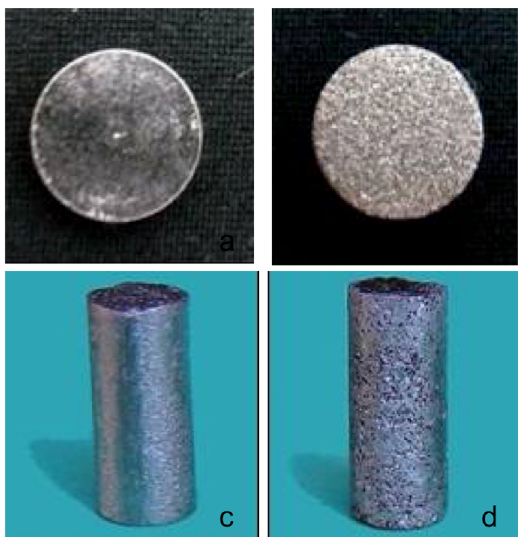
Figure 1. Macrostructure of the samples: a) dense Ti disc sample; b) porous Ti disc sample; c) dense Ti cylindrical implant; d) porous Ti cylindrical